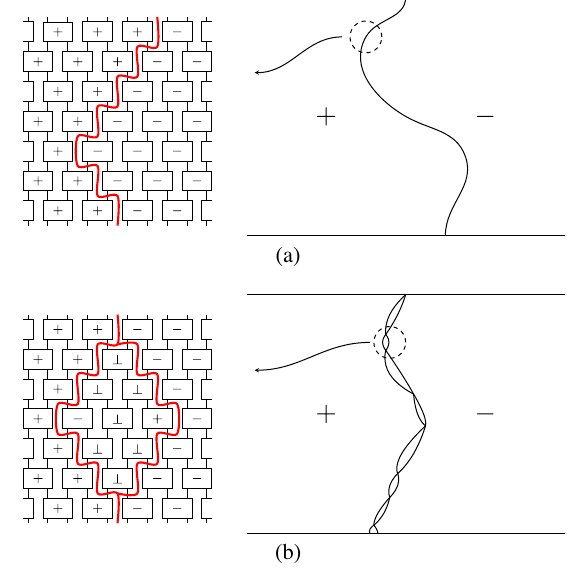
FIG. 4. Domain walls in (a) Z 0 ⊥ (or in the Haar-averaged circuit) and (b) Z , taking into account ⊥ states. In (a), the width of the domain wall is 1. The width of the domain wall in (b) is argued to be of order